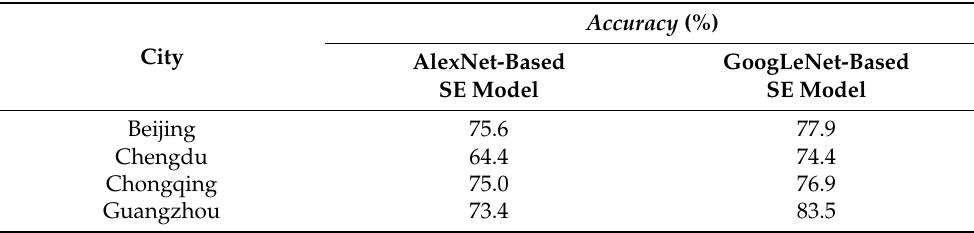
Figure 10. Classification results for the complex road junctions in different cities using the proposed stacking ensemble (SE) method: ( a – d ) Beijing, Chengdu, Chongqing, and Guangzhou, respectively, using the AlexNet-based SE model, ( e – h ) Beijing, Chengdu, Chongqing, and Guangzhou, respectively, using the GoogLeNet-based SE model. Table 8. Classification accuracies of the AlexNet- and GoogLeNet-based stacking ensemble (SE) models for the complex road junctions in the four